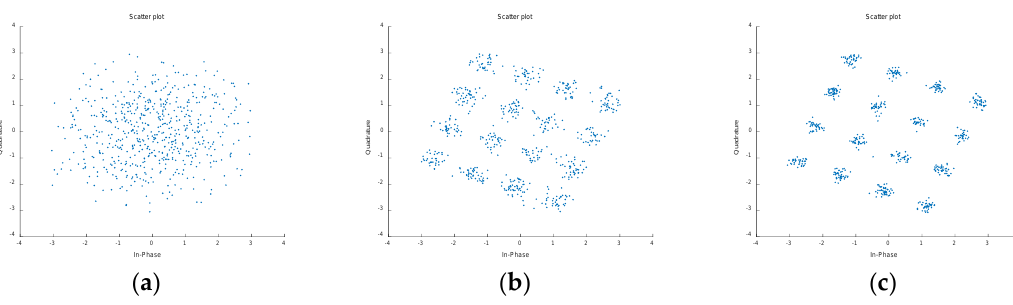
Figure 7. Nonlinearity mitigation results of typical simulation signals for two blind signal separation algorithms.